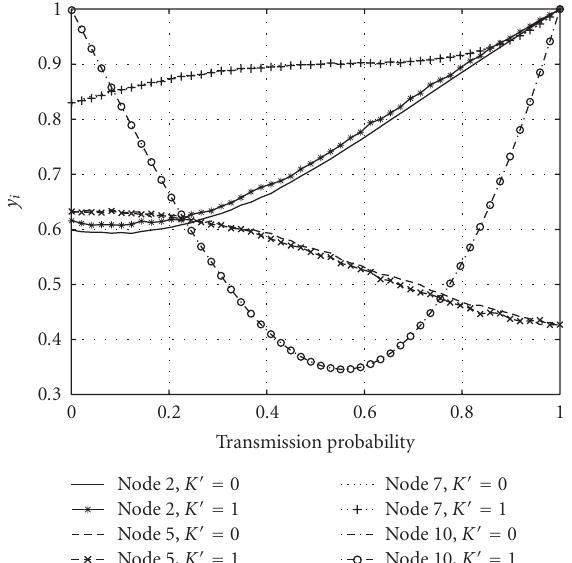
Figure 13: Stability region y i of the dynamic ( K (cid:5) = 1) and static ( K (cid:5) = 0) cases for K = 4 (nodes 2, 5, 7, and 10 of the asymmetric network of Figure 11).